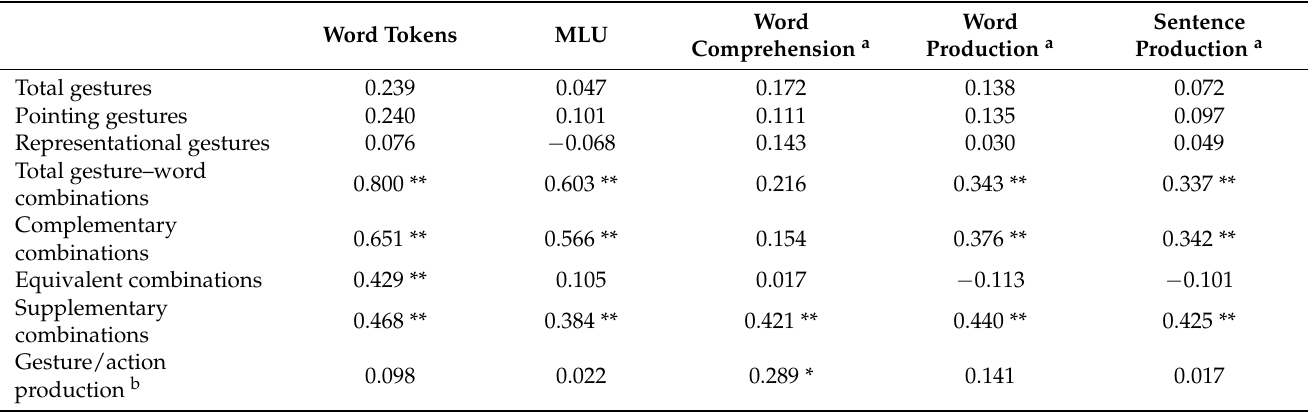
Table 4. Pearson’s correlation coefficients among children’s gestural, lexical, and grammatical